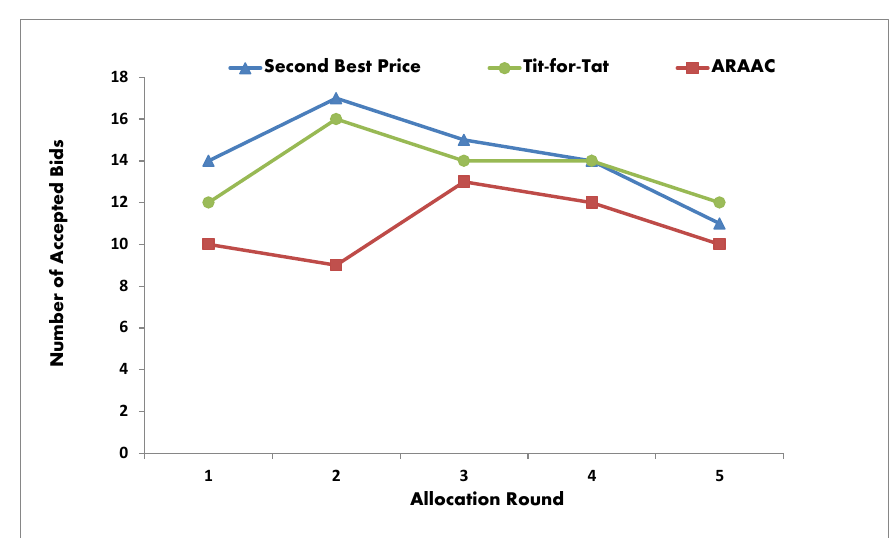
Figure 3. Acceptance rates of the simulated allocation